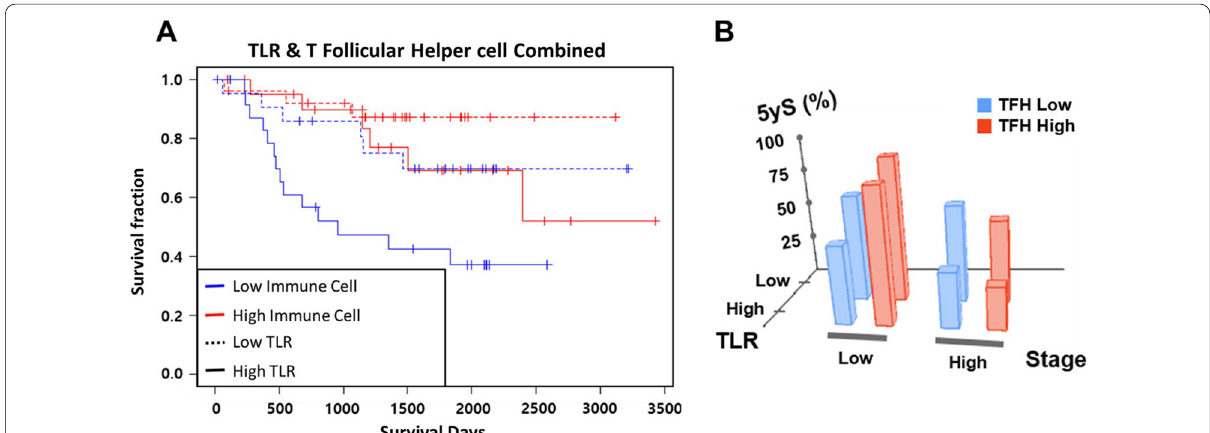
Fig. 8 Prognostic value of combined TLR and T follicular helper cell: A Kaplan–Meier curves of each group divided by the median values of each of the parameters for overall survival. Red, high TFH group; blue, low TFH group; solid line, high TLR group; and dotted line, low TLR group. B Five‑year survival rate for each group divided by the TLR, TFH and stage. TLR and TFH groups were divided by the median value. The low‑stage group consists of patients who are diagnosed as having lung adenocarcinoma at stages 0 or 1 or 2, and the high‑stage group consists of those at stage 3 or stage 4